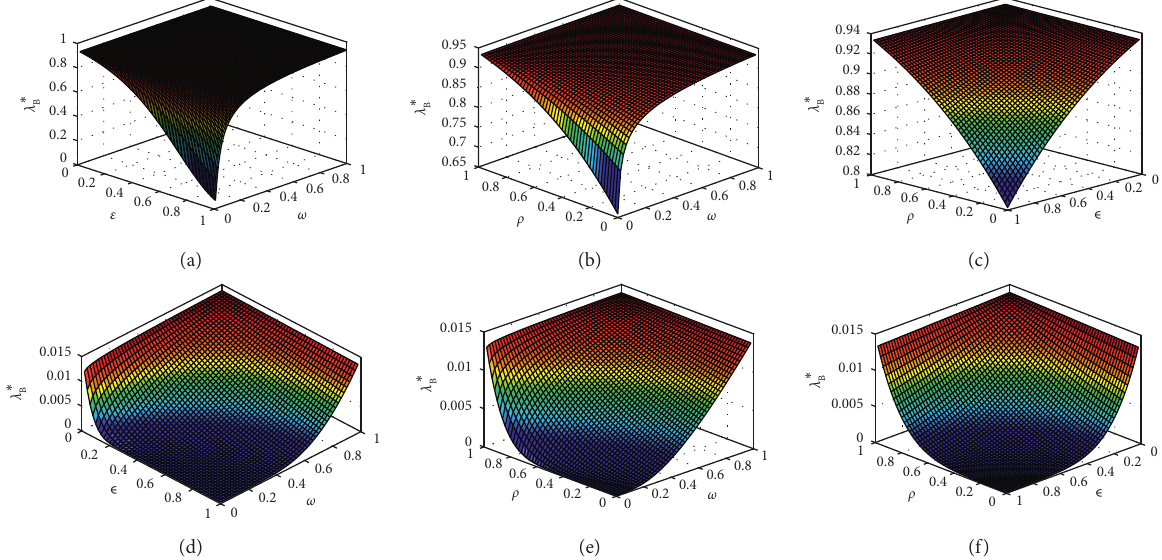
Figure 6: Bank credit-related network under the two network structures and the influence rule of the threshold λ ∗ B of the credit risk transmission rate of the counterparty of the bank network. (a) The influence of bank counterparty business association degree ε and bank counterparty risk resistance ability ω on λ ∗ B in the bank network under the index network. (b) The influence of the bank’s counterparty risk information processing ρ and resistance ω abilities on λ ∗ B in the bank network under the index network. (c) The influence of the processing ability of the bank counterparty risk information ρ and the degree of the bank counterparty’s business relevance ε on λ ∗ B in the bank network under the index network. (d) The influence of the bank transaction counterparty business association degree ε and bank transaction counterparty risk resistance ability ω on λ ∗ B in the bank network under the WS network (node long-distance connection probability p � 0 . 05). (e) The influence of the processing ability of bank counterparty risk information ρ and bank counterparty risk resistance capacity ω on λ ∗ B in the bank network under the WS network (node long-distance connection probability p � 0 . 05). (f) The influence of the bank counterparty ability to process risk information ρ and the degree of the bank counterparty’s business relevance ε on λ ∗ B in the bank network under the WS network (node long-distance connection probability p � 0 . 05).